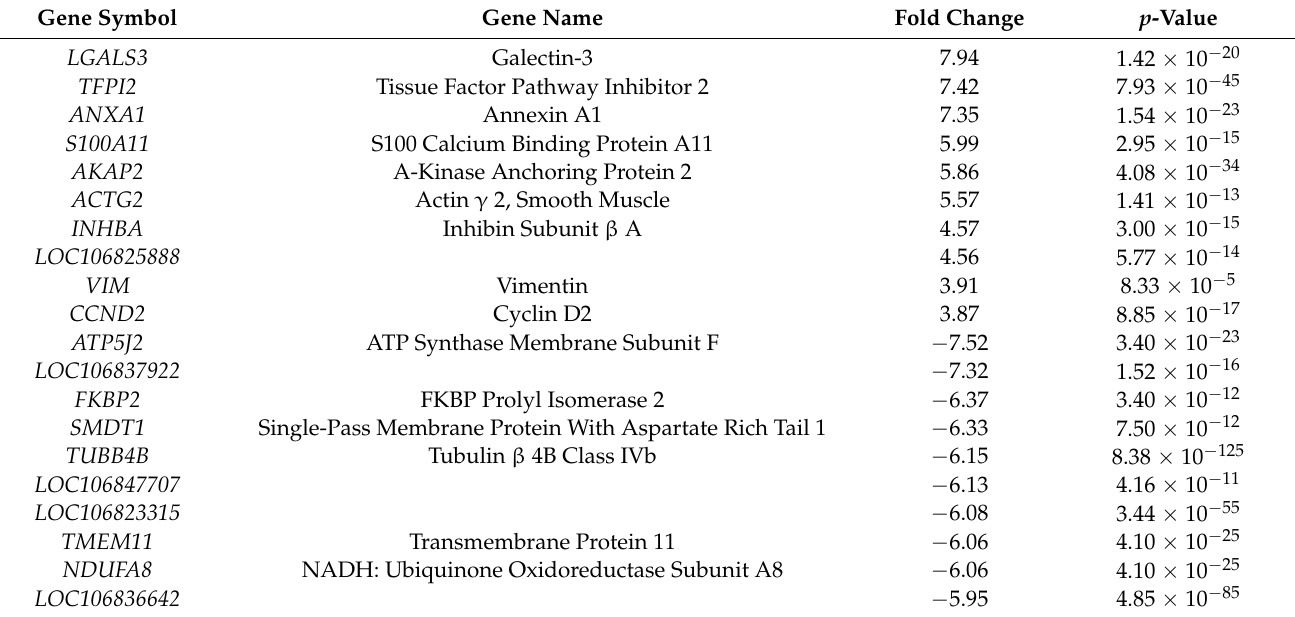
Table 4. Top 10 genes with the highest and the lowest fold changes after oocyte in vitro maturation. Gene